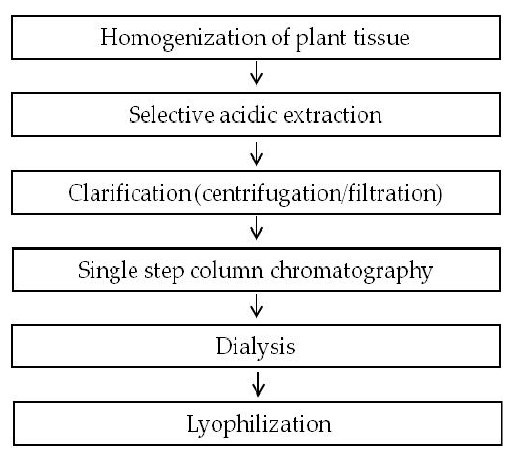
Figure 1. Flowchart of the experimental procedure for colicin purification from plant biomass by selective extraction, cation exchange chromatography, dialysis, and lyophilization.